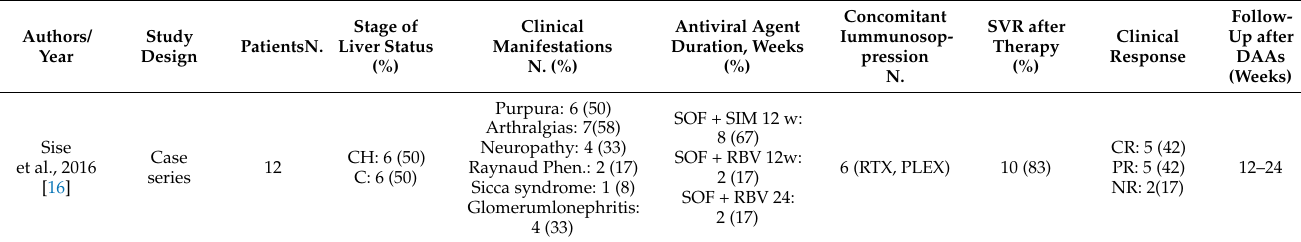
Table 2. DAA therapy in patients ( n ) with hepatitis C virus-related cryoglobulinemic vasculitis. Authors/ Study Year